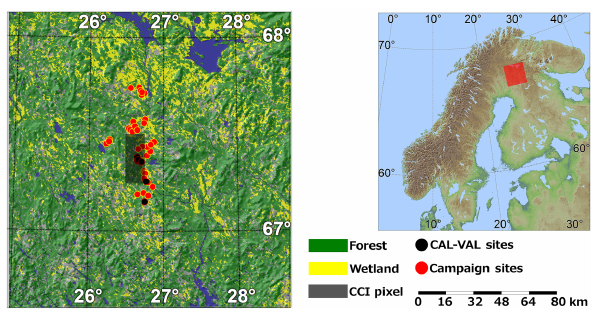
Figure 1. Locations of the Sodankylä study area, FMI’s soil mois- ture CAL–VAL sites, the field campaign measurement sites and the ESA CCI soil moisture data product pixel.